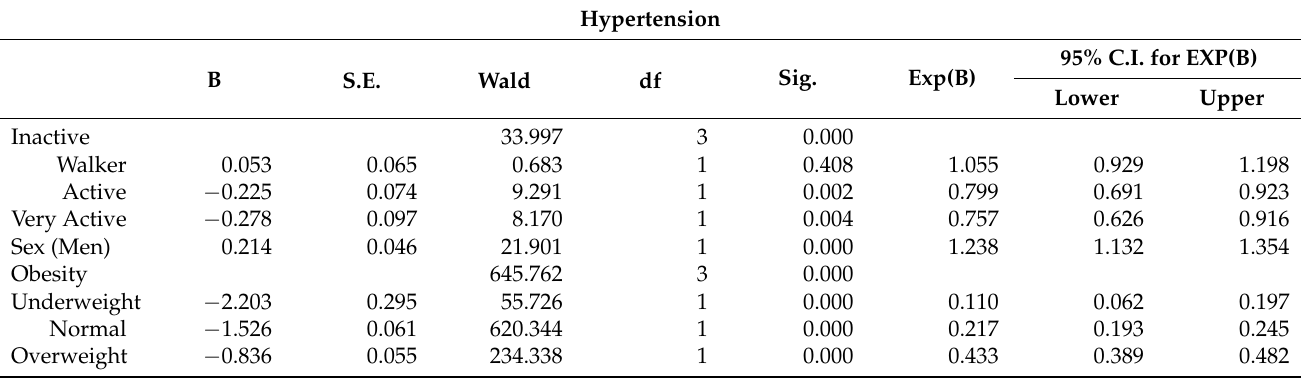
Figure 2. Prevalence of hypertension and the use of antihypertensive drugs, according to the level of physical activity by body mass index (BMI) groups. Table 8. Logistic binary regression model for hypertension and use of antihypertensives risk